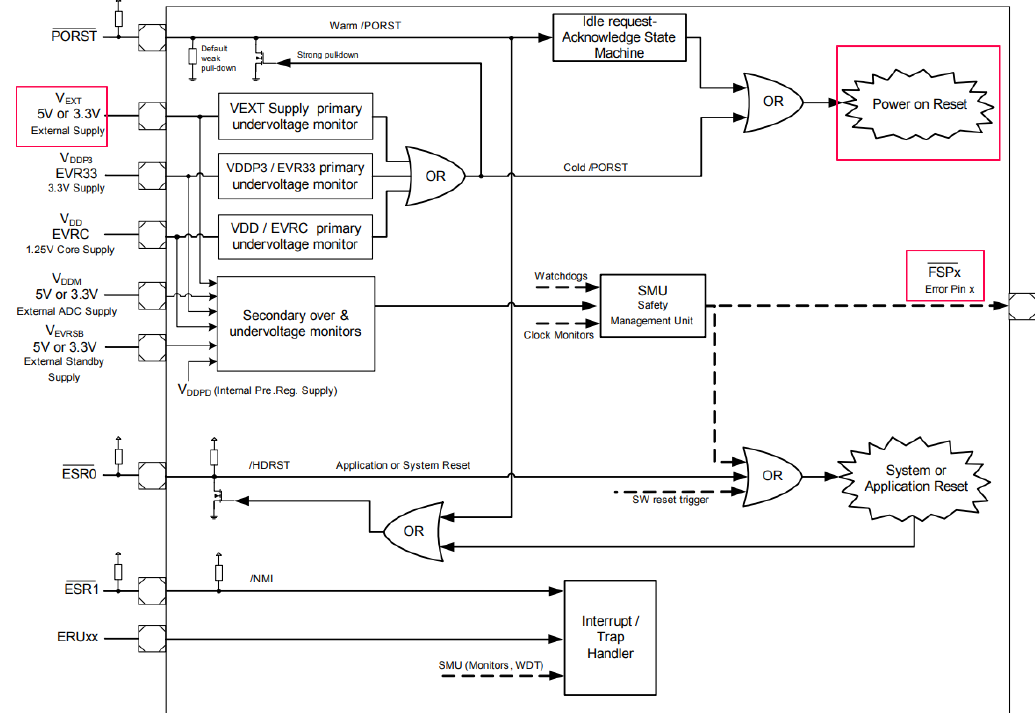
Figure 11. TC397 Power management system block diagram. Reproduced from [4].